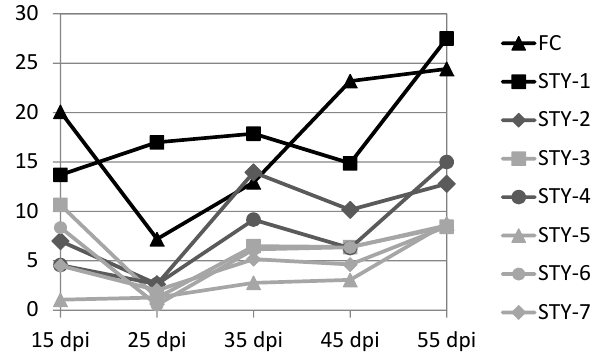
Figure 2. Virus accumulation (ng virus DNA/μg total DNA extracted) in assay 2 at different days post-inocula- tion (dpi) with Tomato yellow leaf curl virus of the STY lines and the susceptible control ‘Fortuna C’ (FC). Genotypes are classified according to symptom development: suscep- tible genotypes in black, intermediate resistance in dark grey and highly resistant in light